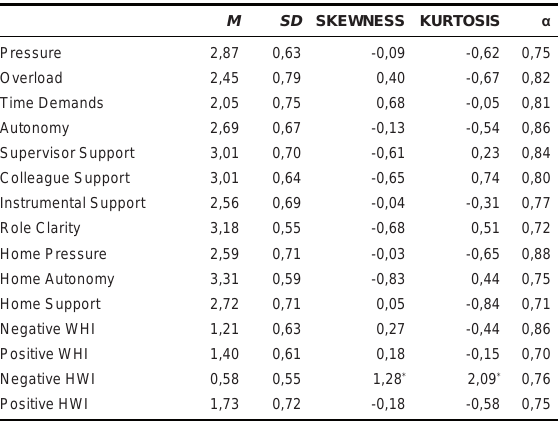
taBLe 2 Descriptive statistics and Cronbach alpha coefficients of the